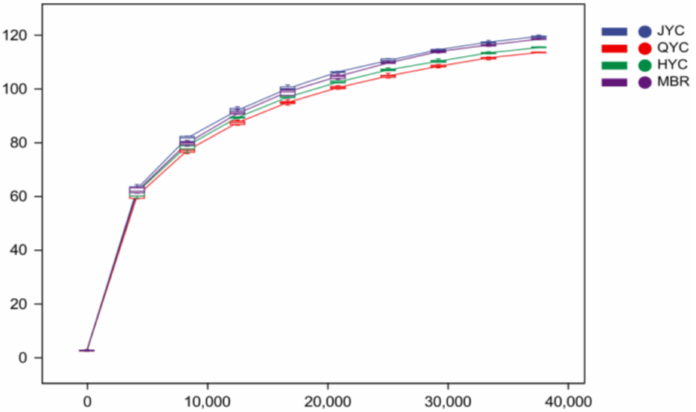
Figure 14. Rarefaction curves of OTUs clustered at 97% sequence identity across the four samples. Table 3. The alpha diversity index of samples JYC, QYC, HYC, and